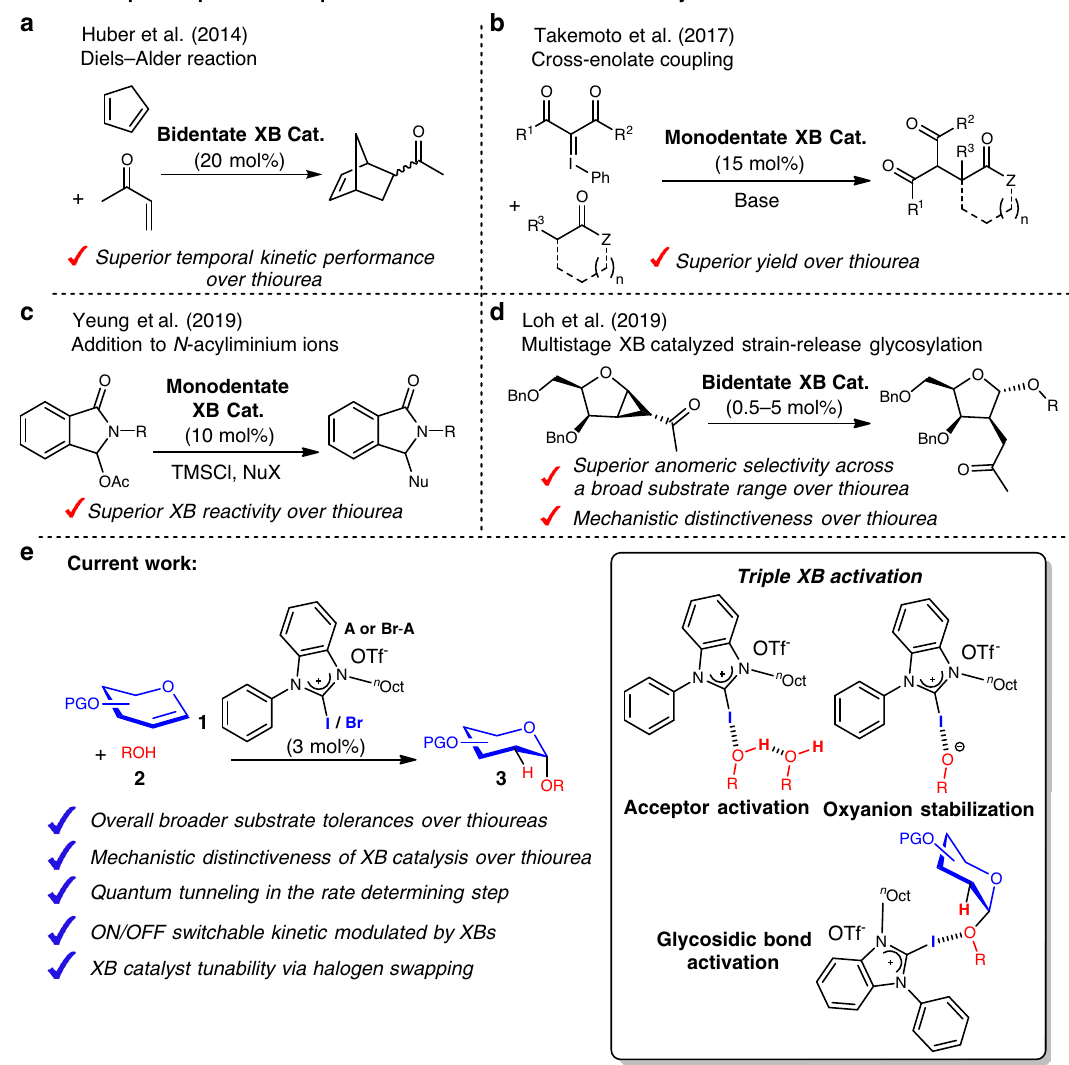
Fig. 1 Prior reports in enhanced XB over thiourea based HB catalysis. a XB-catalyzed Diels – Alder reaction. b XB-catalyzed cross-enolate